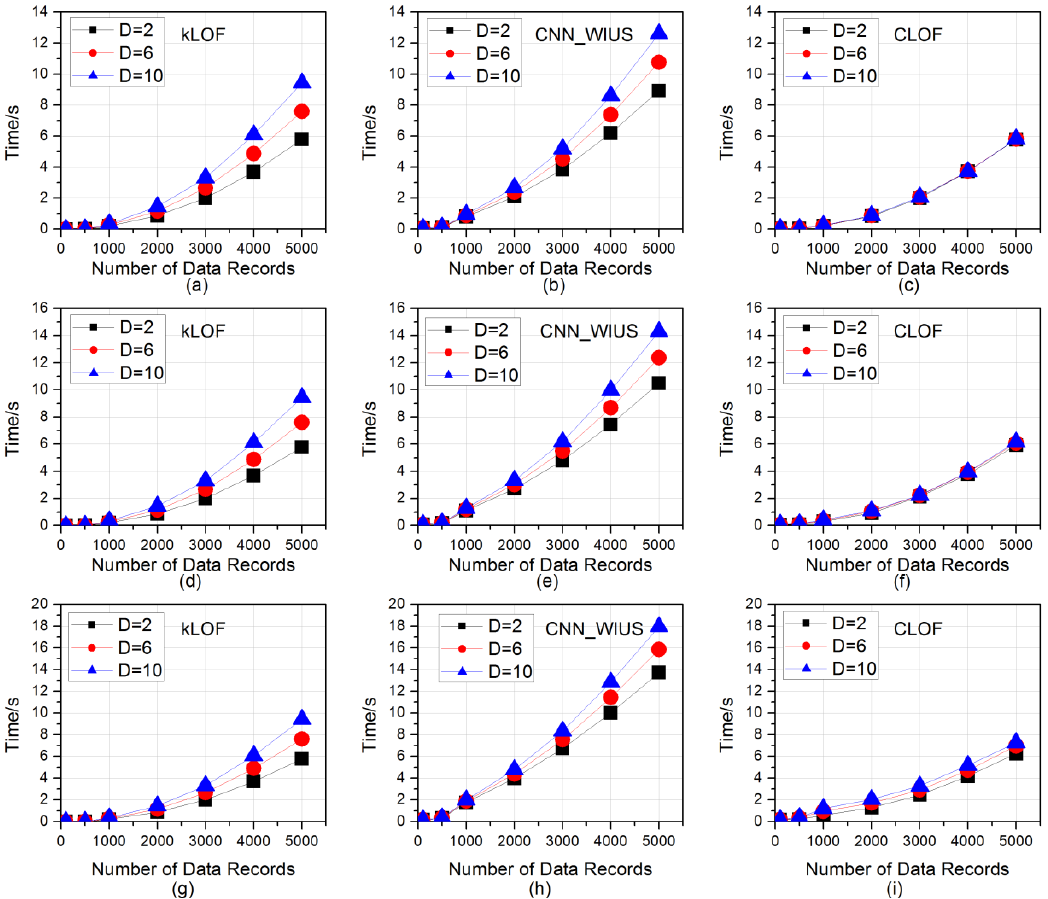
Figure 8. The time for updating local outlier factor on uniform distribution synthetic datasets: ( a – c ) the time at k = 5 and D = 2, 6, 10 respectively; ( d – f ) the time at k = 10 and D = 2, 6, 10 respectively; ( g – i ) the time at k = 20 and D = 2, 6, 10 respectively.